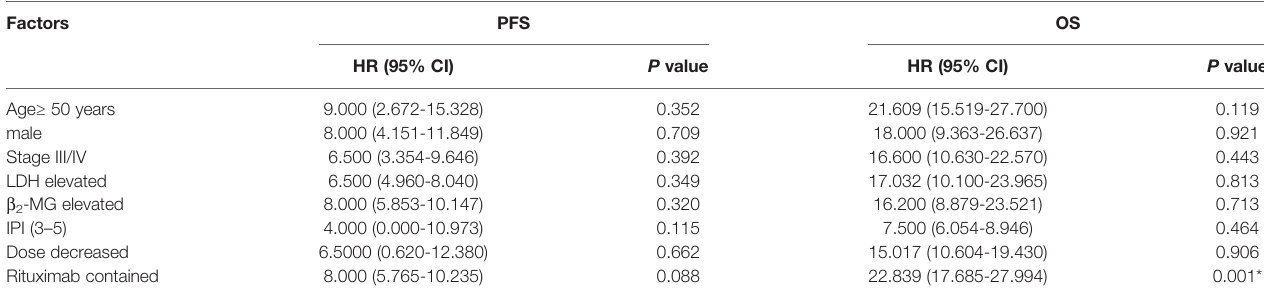
TABLE 6 | Univariate analysis of prognostic factors for PFS and OS. Factors